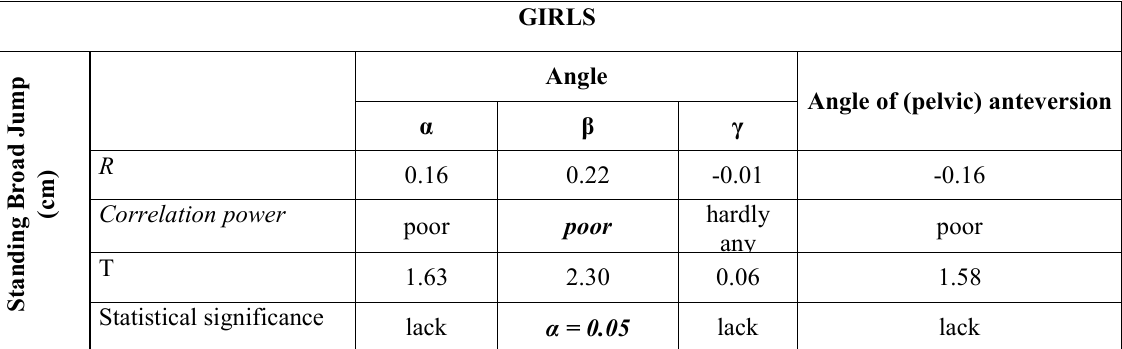
Correlations occurring between the angles characteristic of anterior-posterior pelvic tilts (upper thoracic - α, thoracic- lumbar - β, sacral-lumbar γ) and the angle of pelvic anteversion in the sagittal plane and the number of points scored in the standing broad jump test in the girls involved in the study